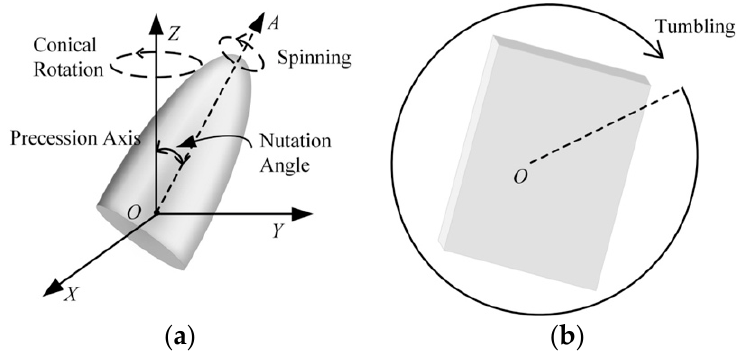
Figure 2. Micro-motion model of ballistic target: ( a ) precession motion; ( b ) tumbling motion.